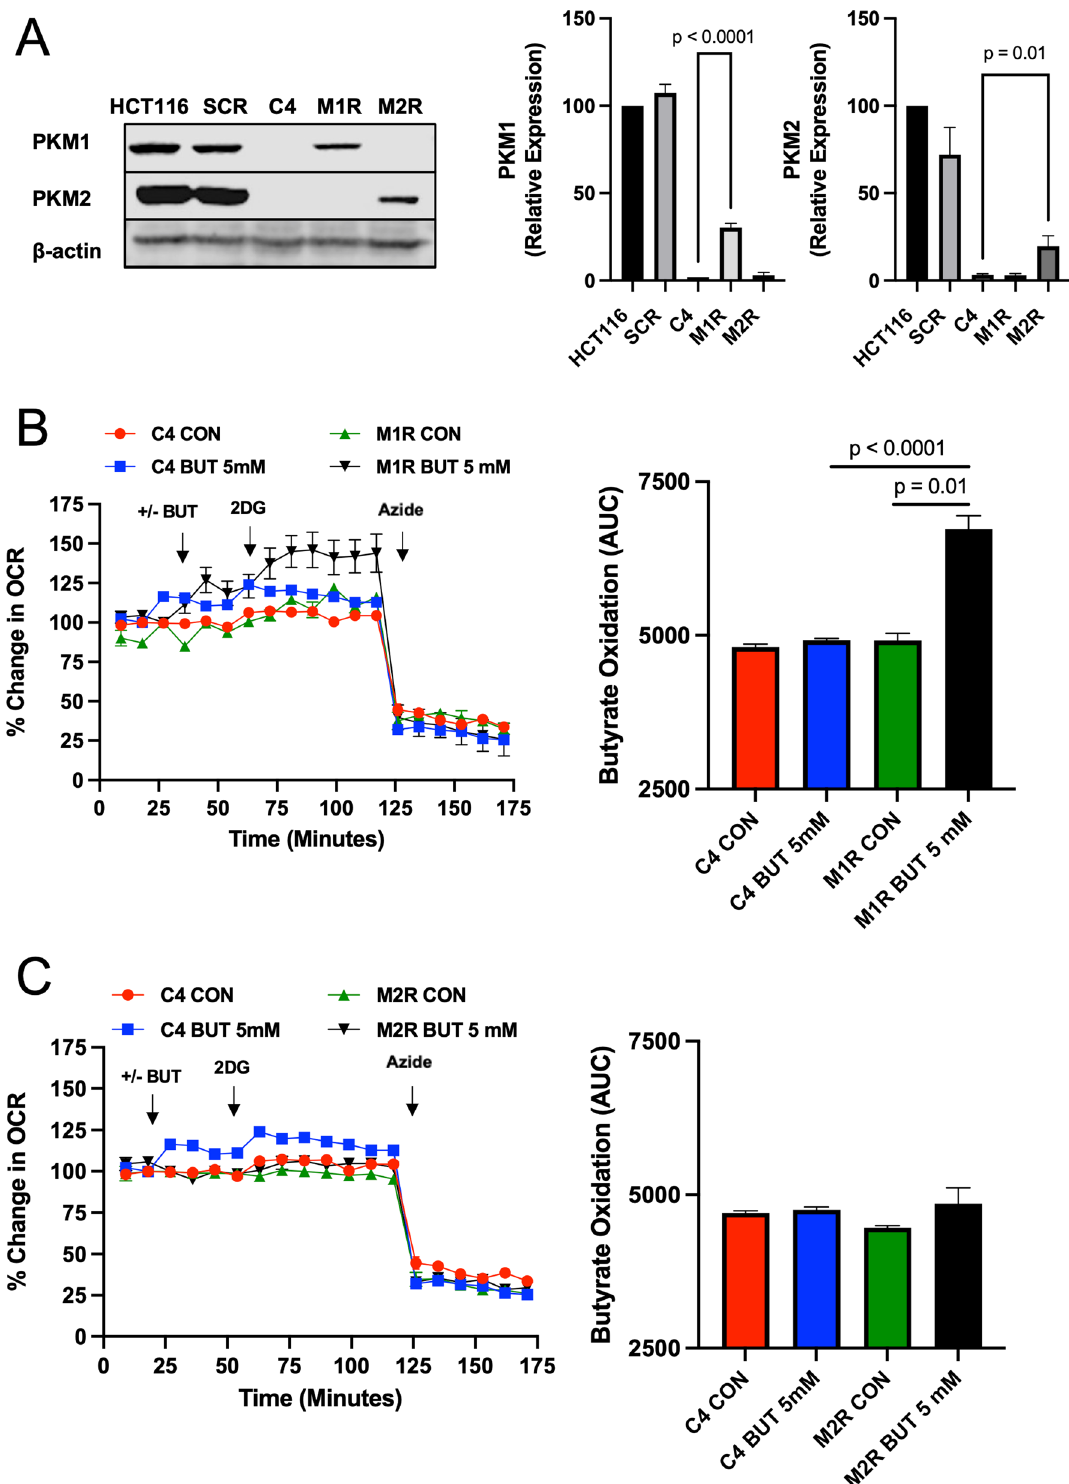
Figure 3. Butyrate oxidation is PKM1 dependent rather than PKM2 in HCT116 colorectal cancer cells. ( A ) Western blot analysis of PKM1 and PKM2 expressions in HCT116, SCR, and re-expressed PKM1 (M1R) and PKM2 (M2R) cells with β-actin as a loading control. Quantification of the western blot is shown in the right panel. For statistical analysis, western blot was conducted 5 times. ( B ) Percent change in oxygen consumption rate (OCR) relative to baseline in which C4 and M1R cells treated with and without butyrate (5 mM). Total contribution of butyrate toward OCR (%) is observed after injection of 2-deoxyglucose (2DG). The right panel shows the area under the curve (AUC) analysis from OCR measurements taken after 2DG injection but before azide injection. These measurements represent butyrate oxidation (arbitrary units). ( C ) Percent change in OCR relative to baseline in which C4 and M2R cells treated with and without butyrate (5 mM). The right panel shows the area under the curve analysis from OCR measurements taken after 2DG injection but before azide injection. These measurements represent butyrate oxidation (arbitrary units). Data points represent the average OCR (%) over 3–5 replicates per condition for butyrate oxidation measurements. Error bars are mean ±